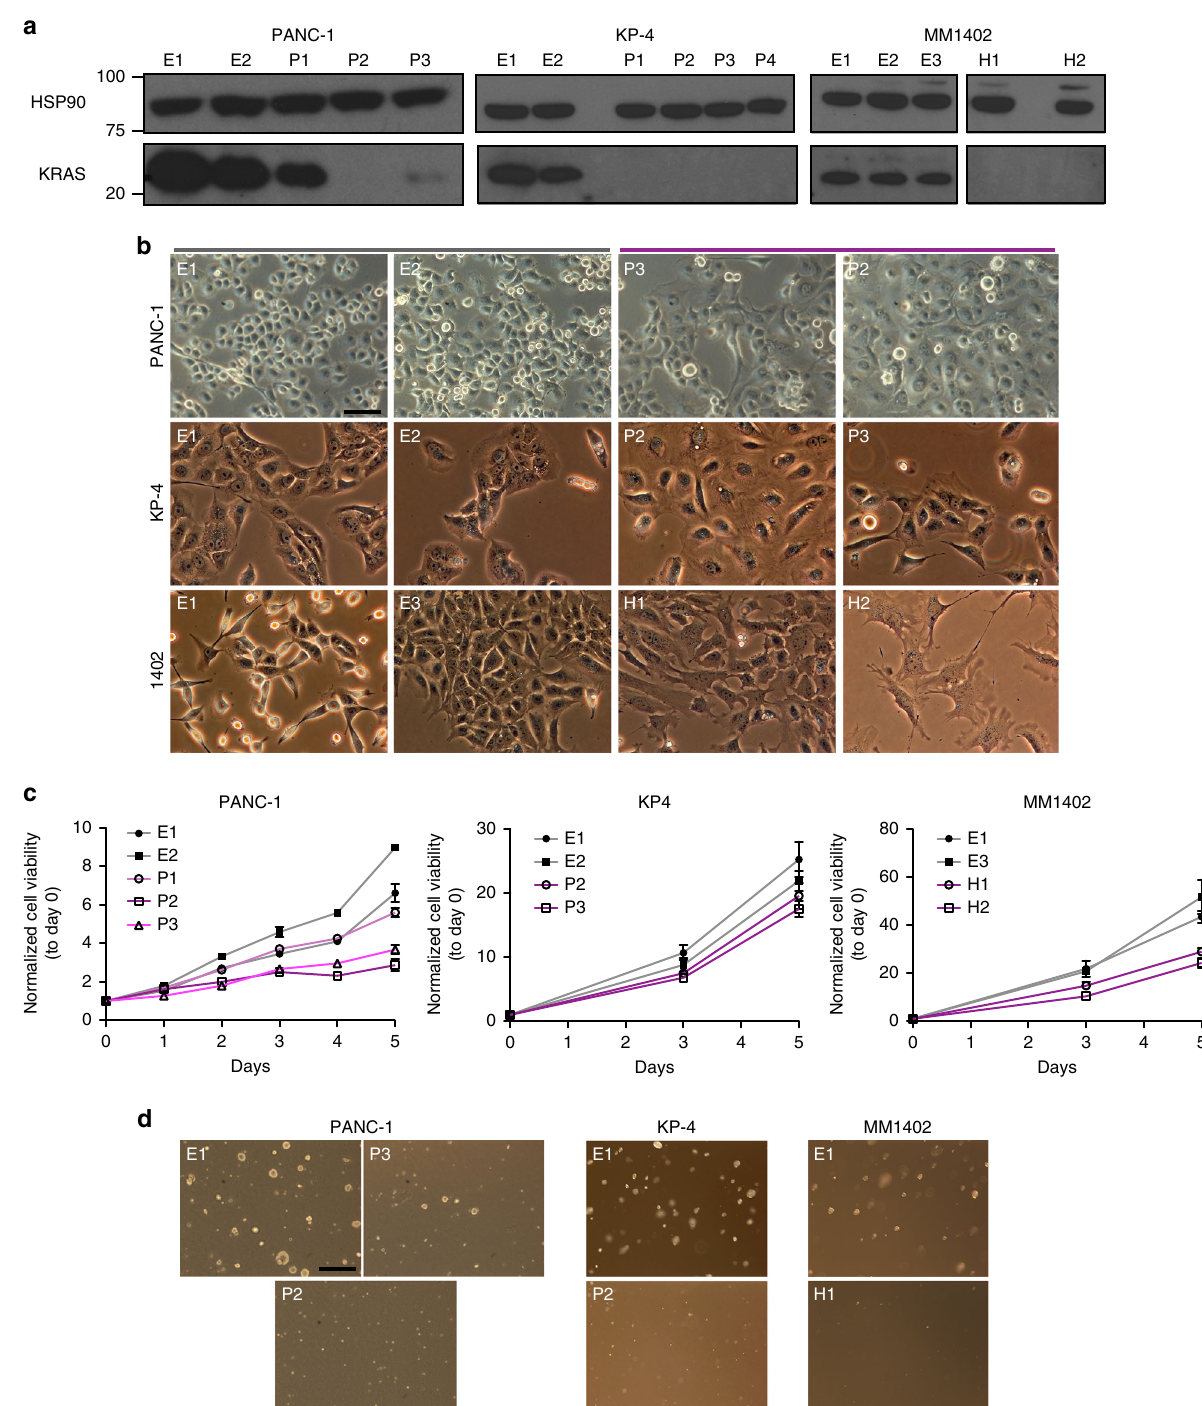
Fig. 2 KRAS is dispensable in a subset of PDAC cell lines. a Western blot con fi rmed loss of KRAS protein in knockout clones derived from PANC-1 (P2 complete, P3 partial), KP-4 (P1, P2, P3, P4), and MM1402 (H1, H2) cell lines compared to intact clones (PANC-1-E1,E2; KP-4-E1,E2; MM1402-E1,E2,E3). HSP90 is loading control. b KRAS de fi cient clones (purple) exhibited altered cell morphology compared to intact cells (gray). Speci fi c differences include increased cell size, cytoplasmic translucency, and smooth edges. Scale bar is 100 µ m. c KRAS de fi cient clones showed diminished proliferation in vitro. Average cell viability (normalized to day 0) ± s.e.m. for each clone is plotted. PANC-1 knockout clone (P2) and partial knockout clone (P3) exhibited a dose-dependent effect of KRAS expression on proliferation compared to intact clones (E1, E2). d PANC-1, KP-4, and MM1402 KRAS de fi cient clones showed diminished soft agar colony formation. PANC-1 cells displayed a dose-dependent effect of KRAS expression on anchorage-independent growth. Scale bar is 500 µ